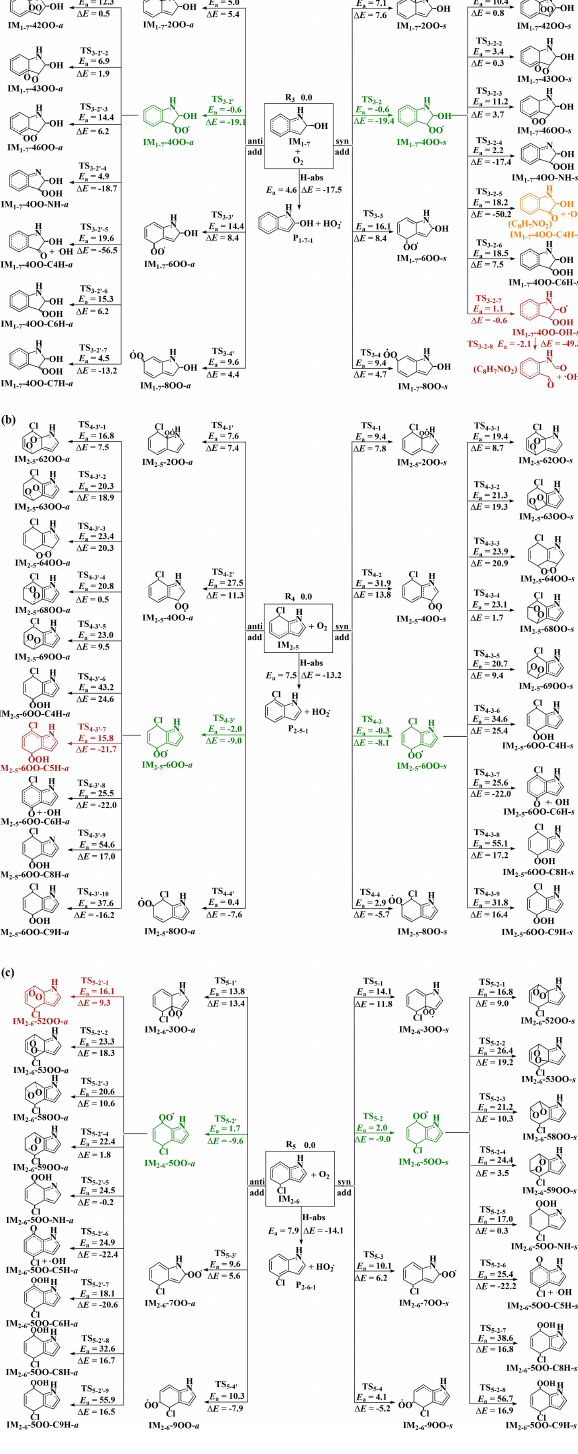
Figure 2. Reaction pathways and corresponding energetic data for the reactions of IM 1 − 7 (a) , IM 2 − 5 (b) and IM 2 − 6 (c) with O 2 . Units are in kcalmol − 1